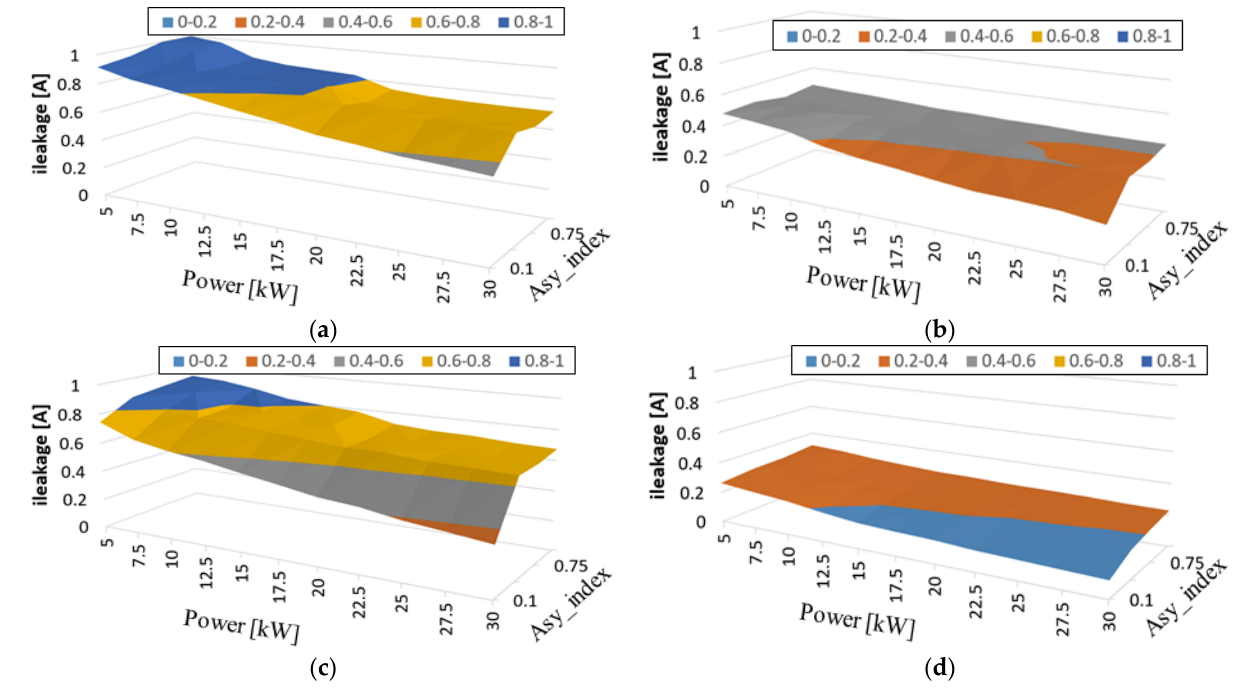
Figure 11. Comparison of leakage current performance of a four-leg inverter under unbalanced load condition: ( a ) two-level three-leg four-wire type, ( b ) two-level four-leg type, ( c ) three-level three-leg four-wire type, and ( d ) three-level type four-leg inverter.